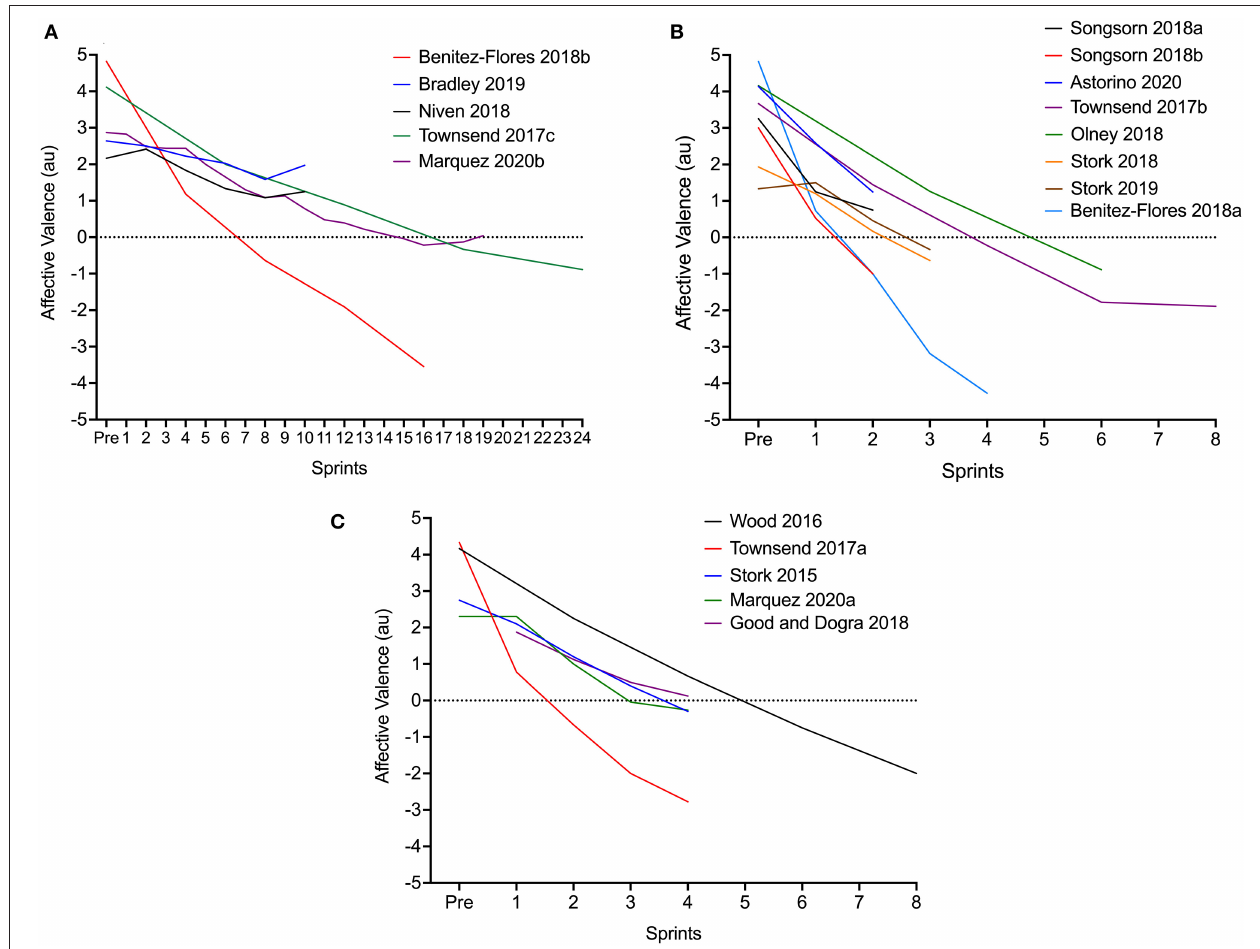
FIGURE 2 | Linear decrease in affective valence during SIE employing short [5–6s; (A) ], medium [15–20s; (B) ] or long [30-s; (C) ]